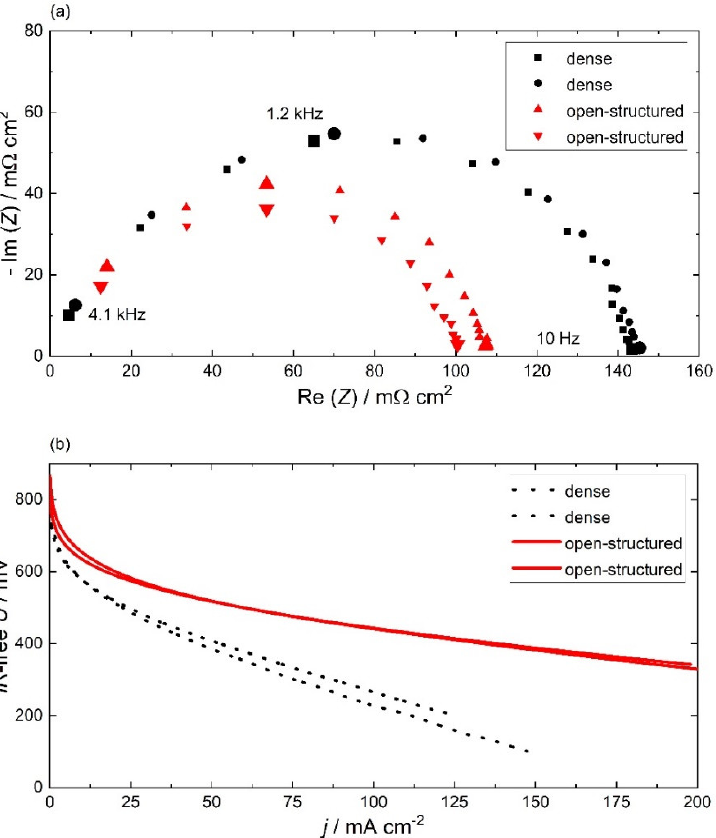
Figure 3. Electrochemical performance: ( a ) Nyquist plot of 60 nm thick dense and open-structured GDE impedance measured under anodic fuel cell conditions (513 K, 60 sccm H 2 and 0.3 atm H 2 O). The enlarged data points indicate the measurement frequencies and are added for orientation. ( b ) Polarization curves of the dense and open-structured MEAs under fuel cell operation conditions (513 K, 30 sccm O 2 , 30 sccm H 2 , 0.3 atm H 2 O). Both measurements were corrected for ohmic losses. The dense and open-structured electrodes are marked in black and red,